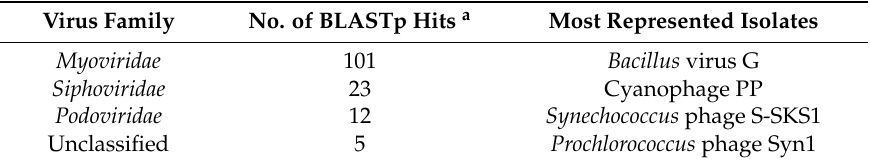
a Number of putative proteins with 30% or more